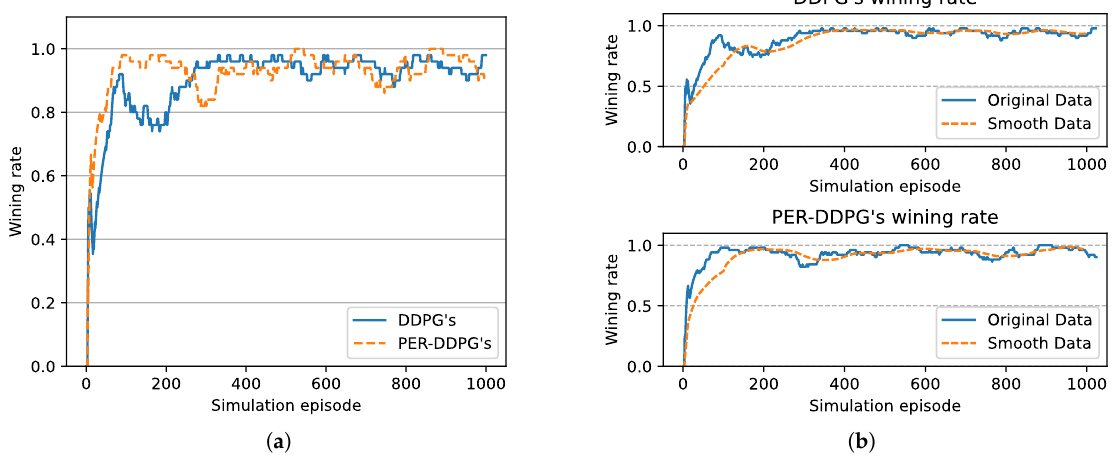
Figure 8. The winning rate of algorithms based on UER-DDPG and PER-DDPG over simulation episode. Winning rate means a rate of finishing mission successfully. ( a ) The comparison of winning rate based on UER-DDPG and PER-DDPG. ( b ) The top figure is the winning rate of algorithm based on UER-DDPG, and the figure at the bottom is the winning rate of algorithm based on